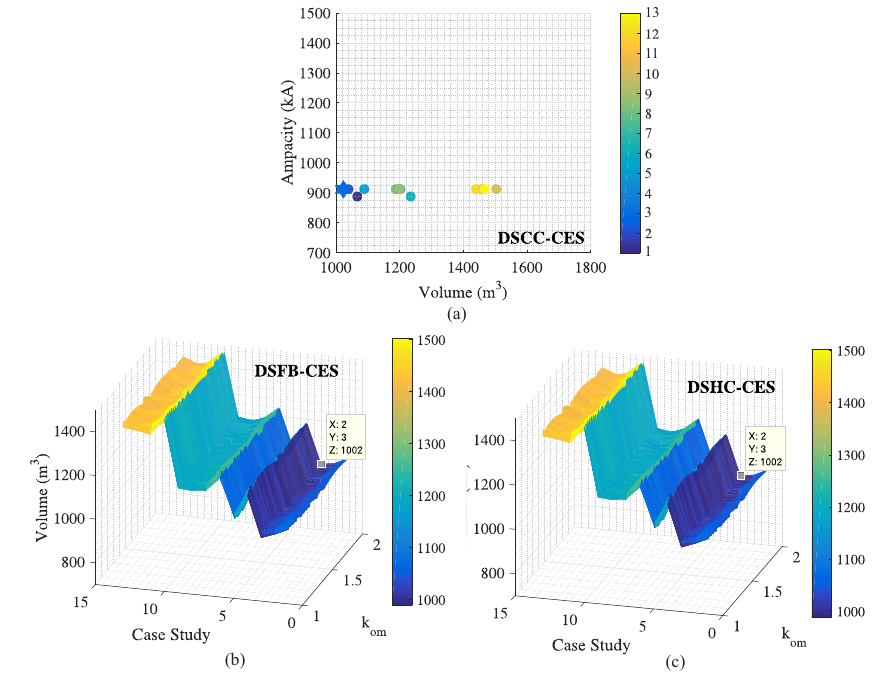
Figure 6. Design outputs for CES topologies considering the SOC from 0% to 100%: ( a ) Ampacity versus volume map for DSCC-CES. ( b ) Volume of DSBC-CES topology for different over-modulation factors. ( c ) Volume of DSHC-CES topology for different over-modulation factors. The colors in ( a ) indicate the case study from Table 2. In ( b , c ), the colors indicate the total volumes of